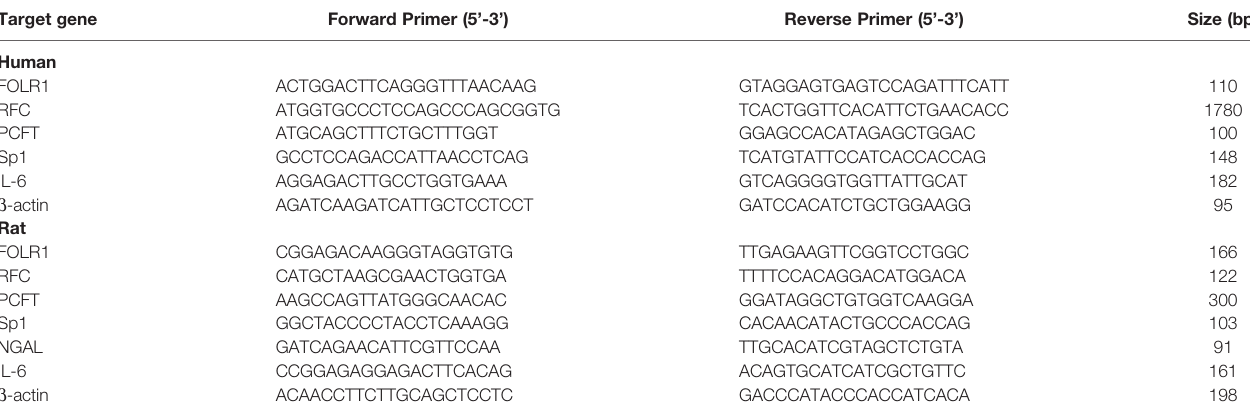
TABLE 1 | Gene primer sequences of human and rat used for real-time PCR. Target gene